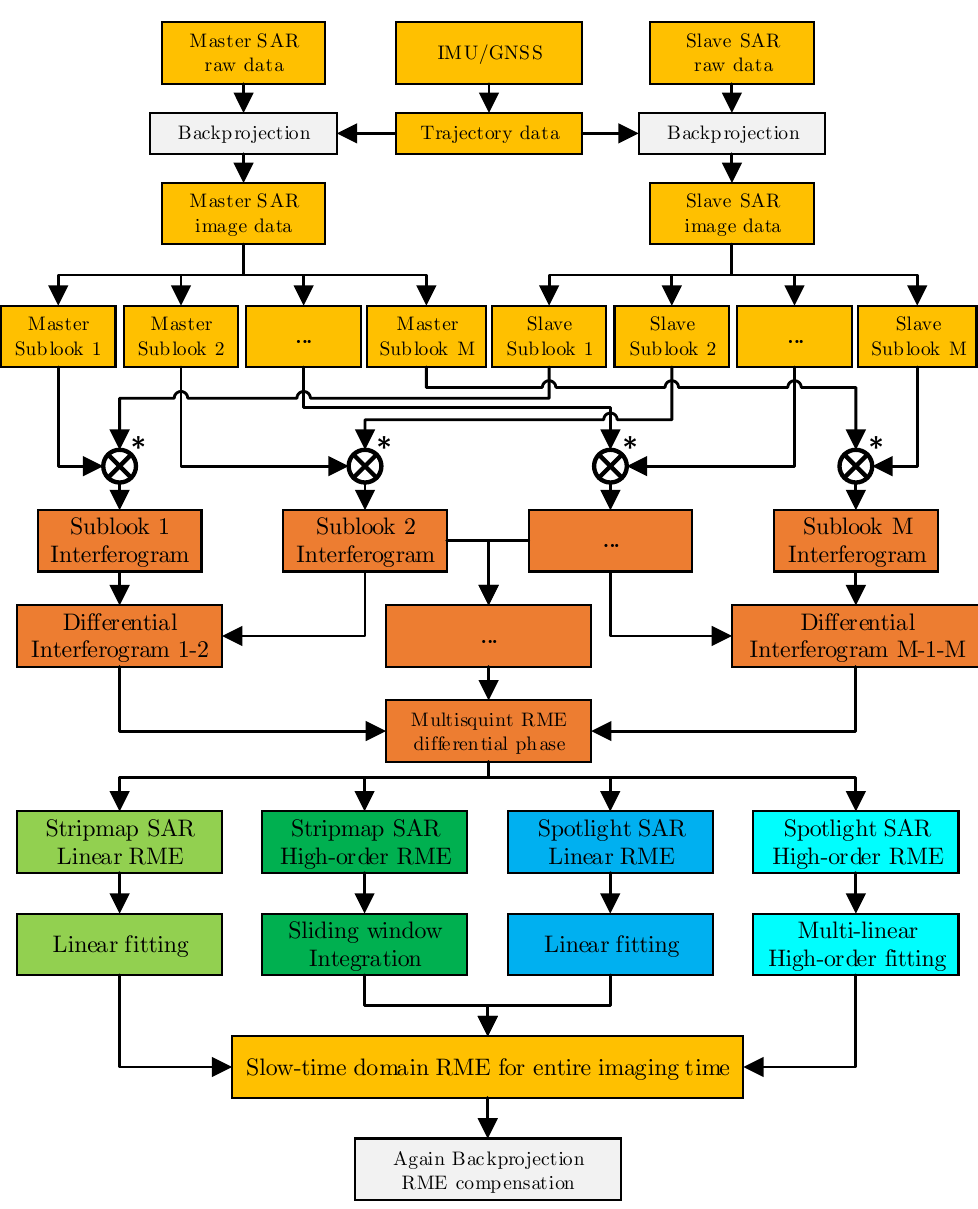
Figure 3. Flowchart of proposed BP-MSQ